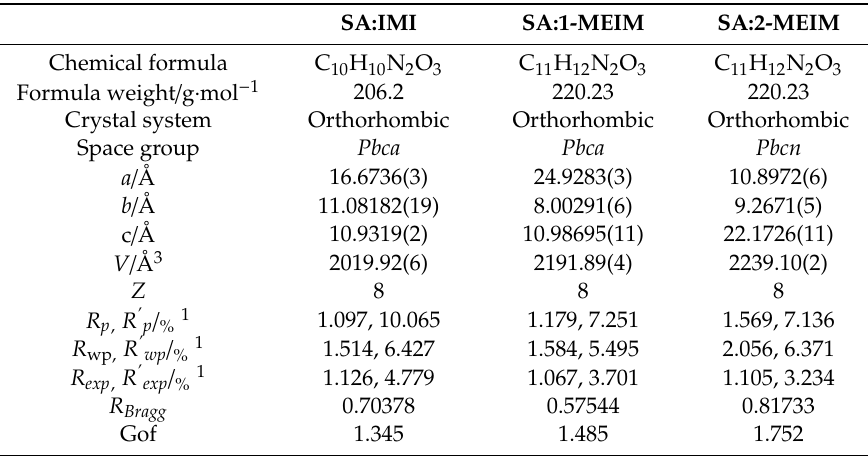
Table 1. Crystallographic details for salicylic acid (SA)